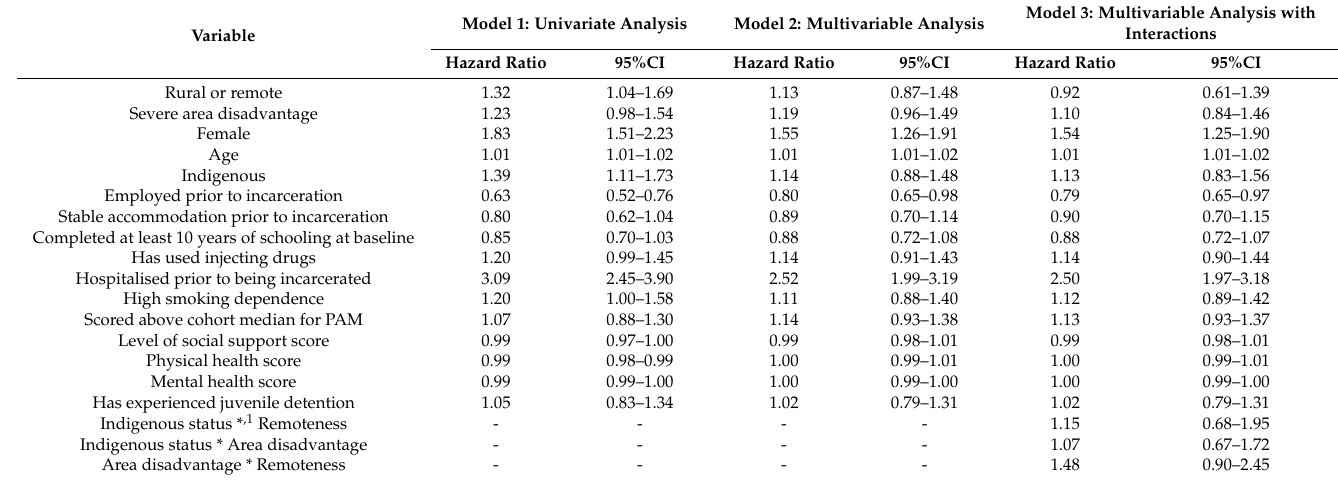
Table 3. Risk of hospitalisations—univariate, multivariable and multivariable with interactions.